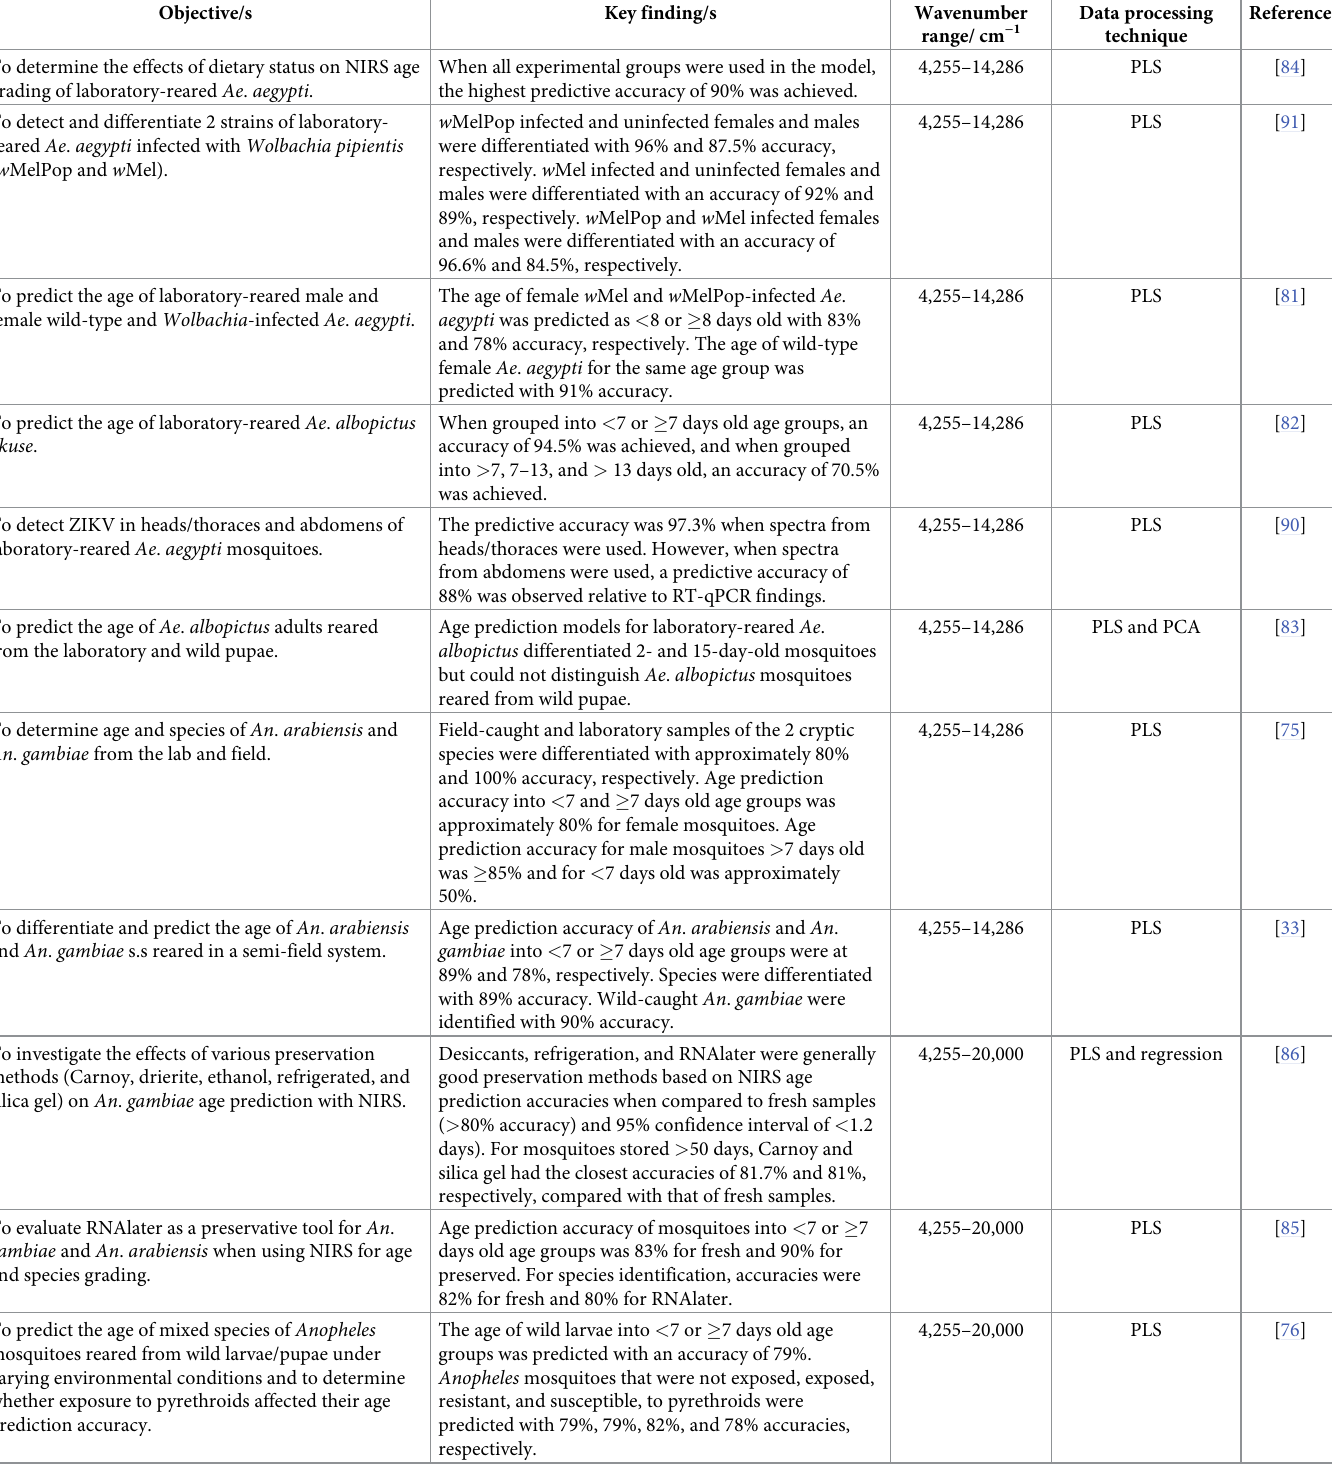
Table 6. A summary of articles reviewed that applied Visible-NIRS for diagnosis and surveillance of malaria and arbovirus vectors. All studies on surveillance of mosquito vectors were conducted using a LabSpec NIR spectrometer (Malvern Panalytical, Malvern, UK).